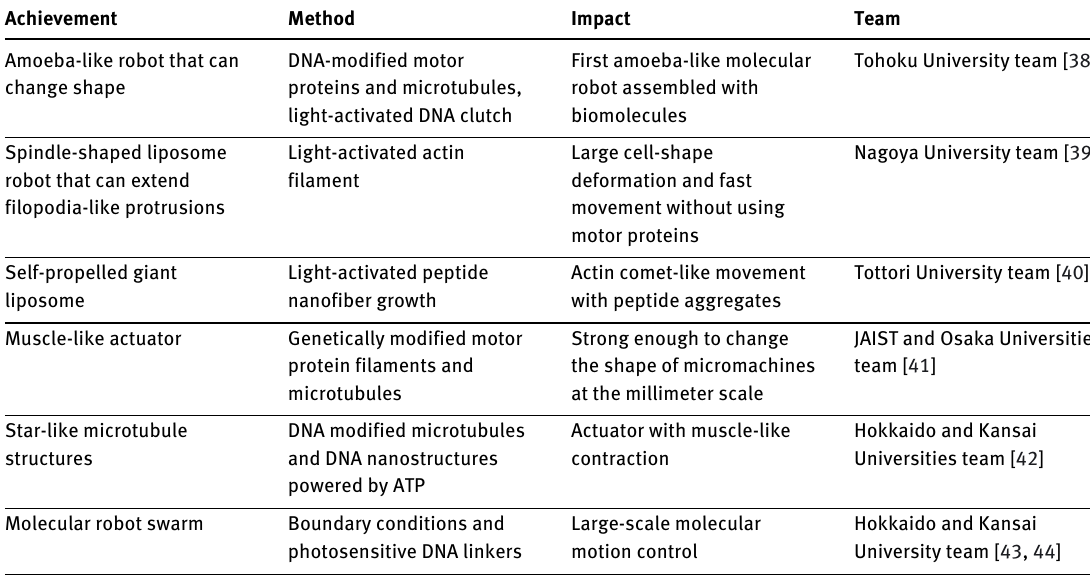
Table 2: Molecular robot